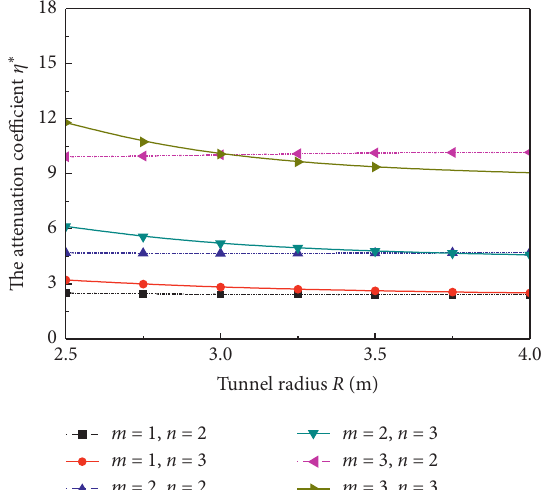
Figure 7: Relationship between attenuation and tunnel wall thickness for different modes, where η � 1.0 × 10 6 Pa ·